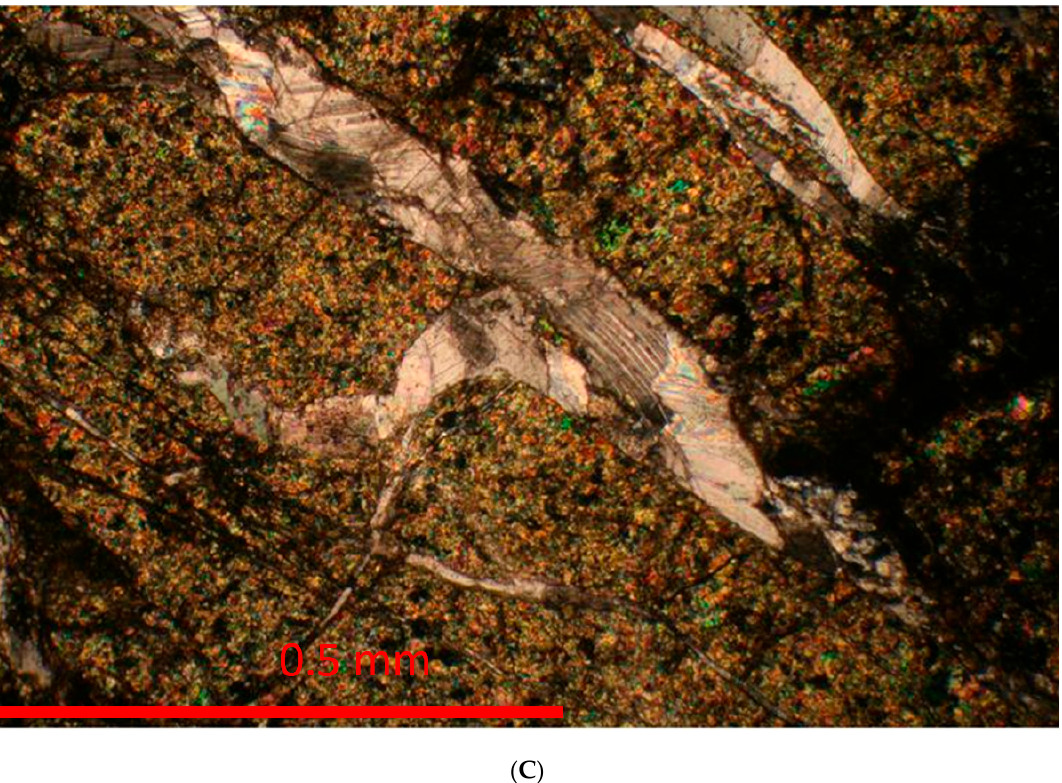
Figure 5. ( A ) Example of sulfides, Hzradan. Pyrite and Chalcopyrite with Arsenopyrite and Tenantite disseminated in the silicate gangue. Field of view is 1 mm. Reflected light; ( B ) Calcite-quartz-epidote skarn showing coarse aggregates of re-crystallized quartz-calcite and epidote porphyroblasts after garnet group phase. Field of view 1 mm. Cross nicol, transmitted light. ( C ) An example of calcite veins cutting through very fine-grained epidote. Field of view 1 mm. Cross nicol, transmitted light.